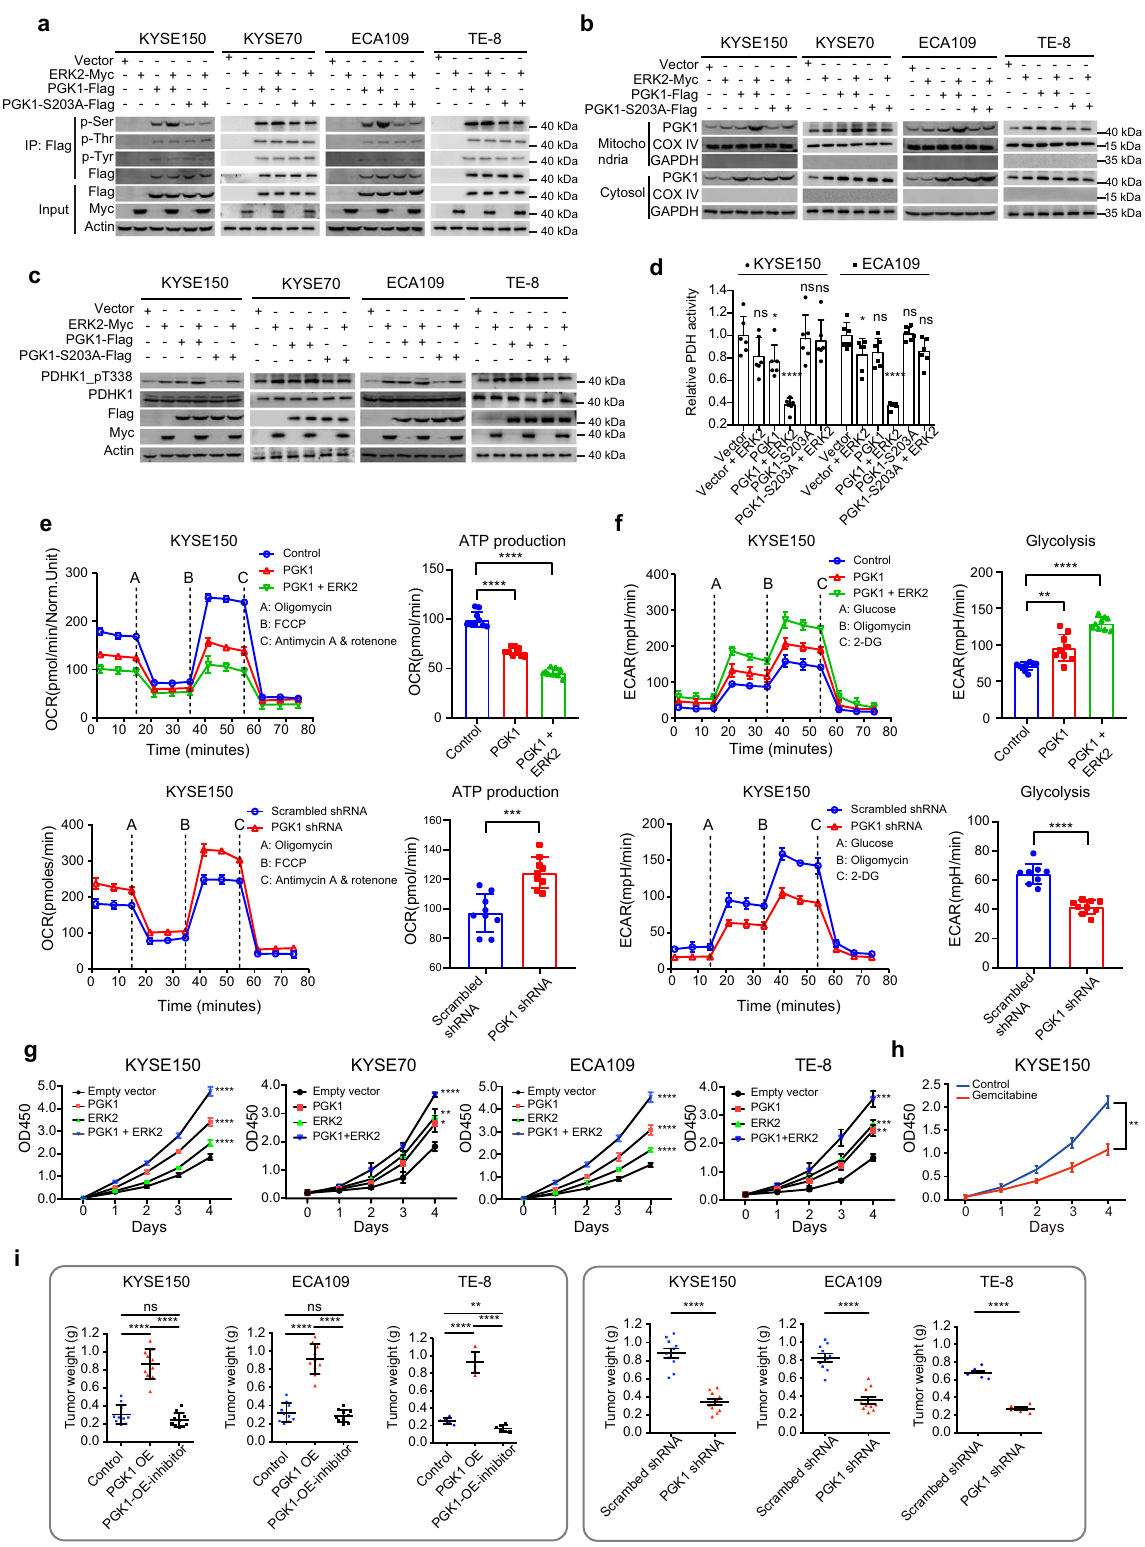
FlagERK2-Myc PGK1-Flag p-Ser ActinMycFlagFlagp-Tyrp-Thr InputIP: